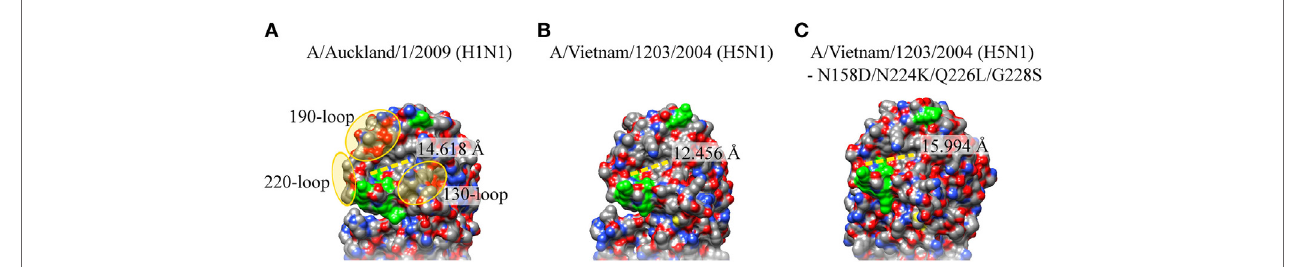
FigURe 2 | Crystal structure of hemaglutinin (HA) sialic acid residue binding site of H1N1pdm09, H5N1, and airborne-transmissible H5N1. The sialic acid residue binding site on the HA of (A) A/Washington/5/2011 (H1N1pdm09; PDB: 4LKX), (B) A/Vietnam/1203/2004 (H5N1; PDB: 2FK0), and (C) H5N1 with Asn148Asp, Gln222Leu Asn224Lys Gln226Leu, and Gly228Ser. These amino acid residues were changed in silico and modeled using HA of H5N1(PDB: 2FK0) as a template in SWISS-MODEL. Protein visualization and distance calculation was performed in UCSF Chimera molecular visualization